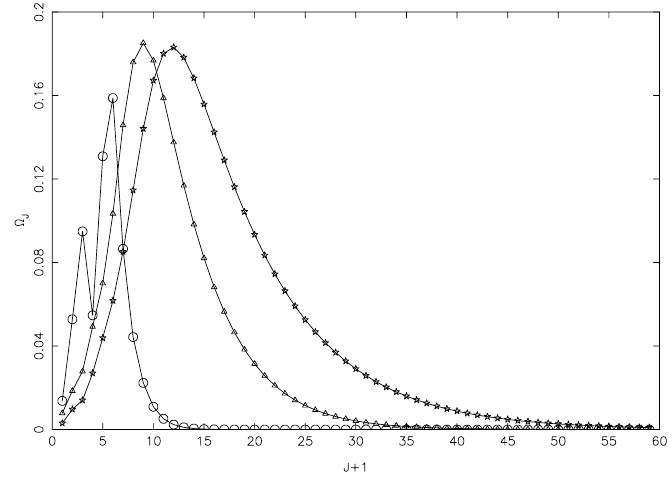
Figure 2. Partial collision strengths for the 2s 2 S 1/2 –3p 2 P o of: 4 Ryd (circles), 6 Ryd (triangles) and 8 Ryd